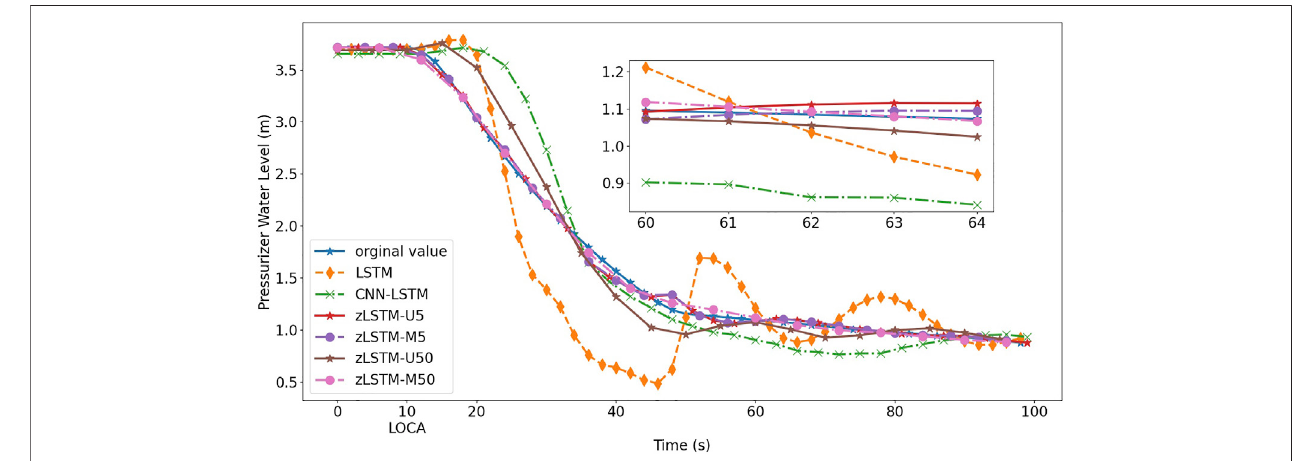
FIGURE 6 | Prediction of pressurizer water level on break size 0.9 cm 2 .